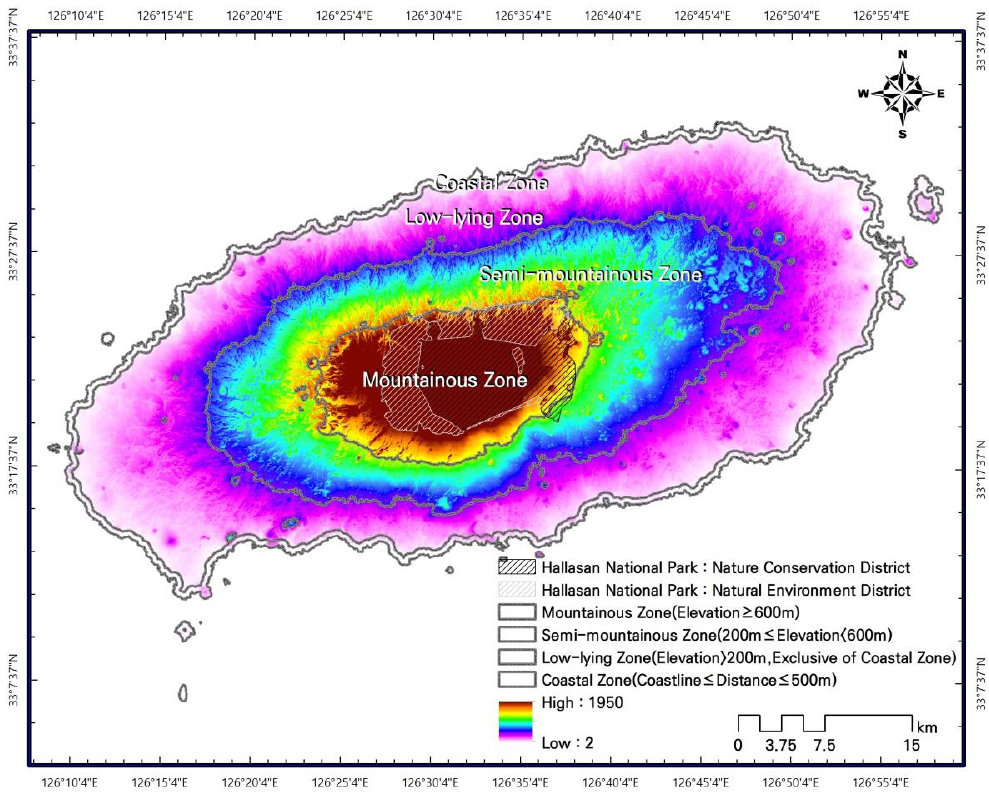
Figure 1. Study area.